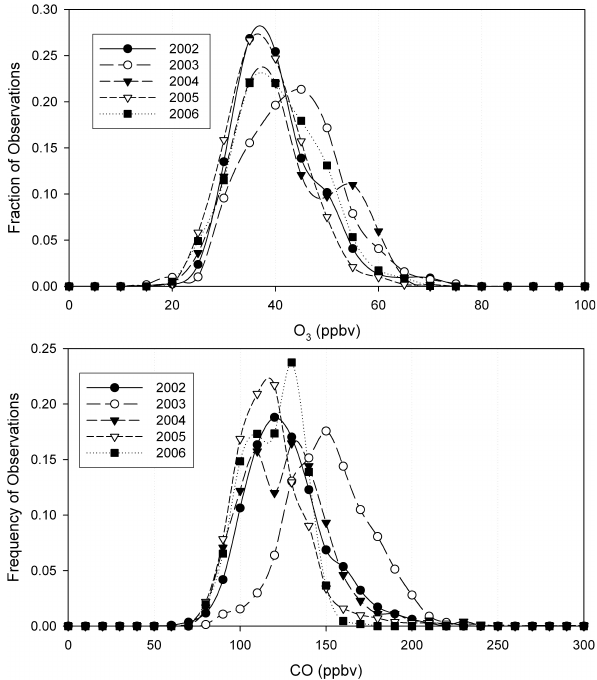
Fig. 4. (a) Frequency distributions of O 3 mixing ratios for June–August 2002–2006; (b) Frequency distribution of CO mixing ratios for June–August